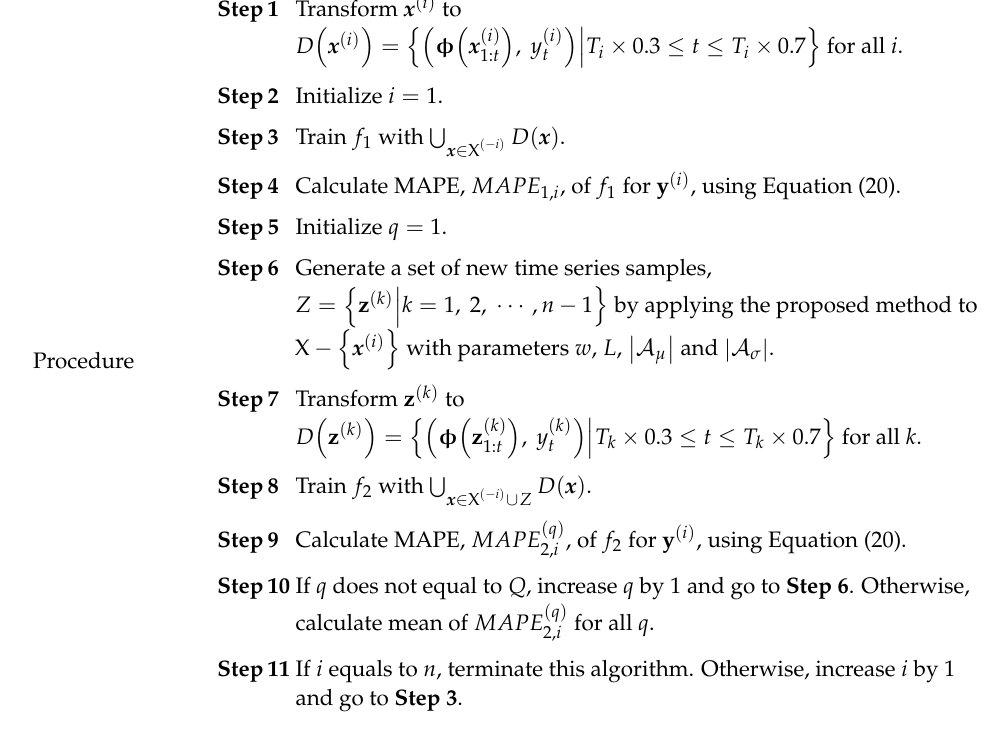
Algorithm A3. Procedure of the